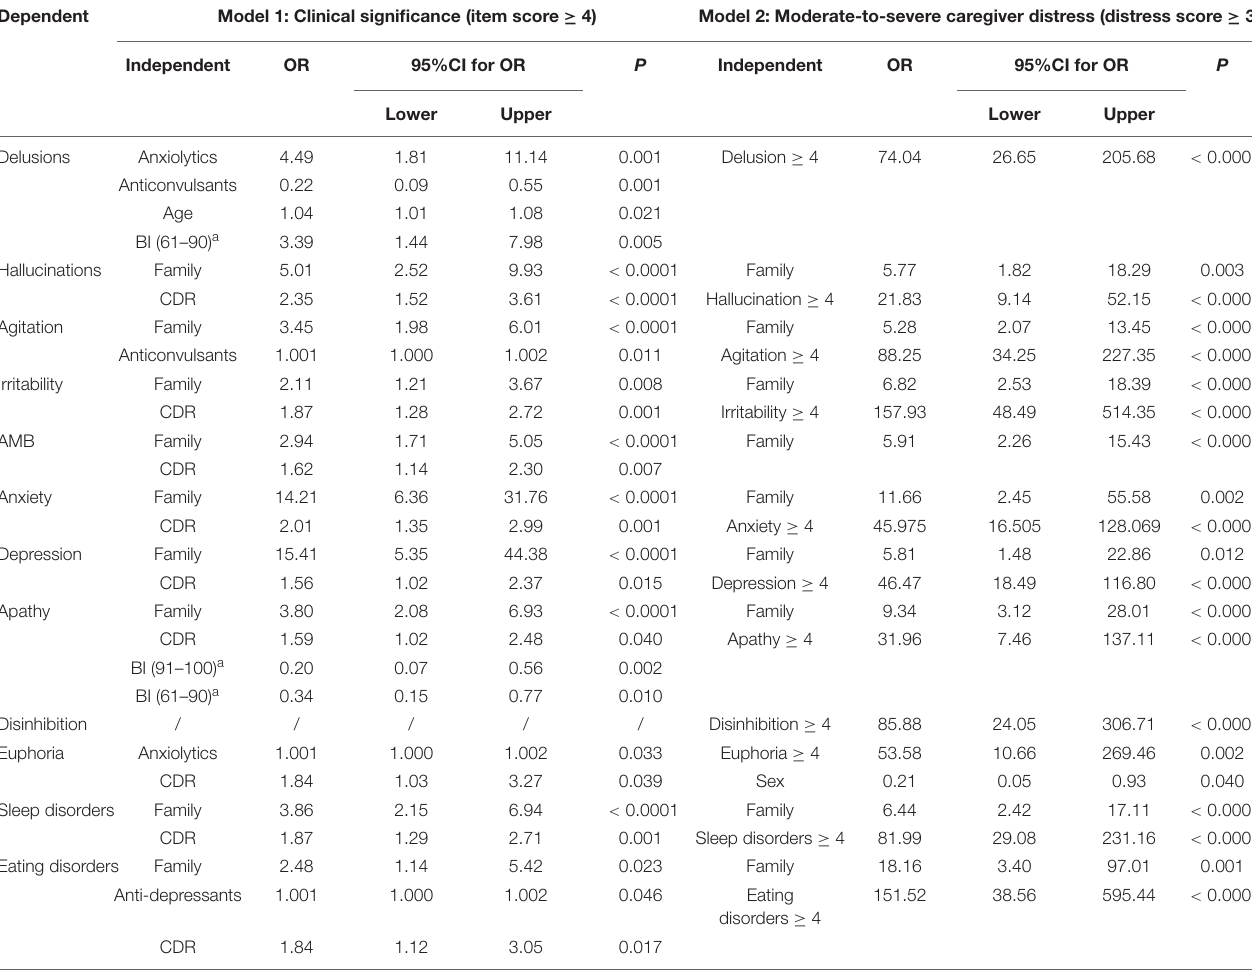
TABLE 2 | Odds ratios of presenting clinically significant symptoms and moderate-to-severe caregiver distress caused by the symptoms. Dependent Model 1: Clinical significance (item score ≥